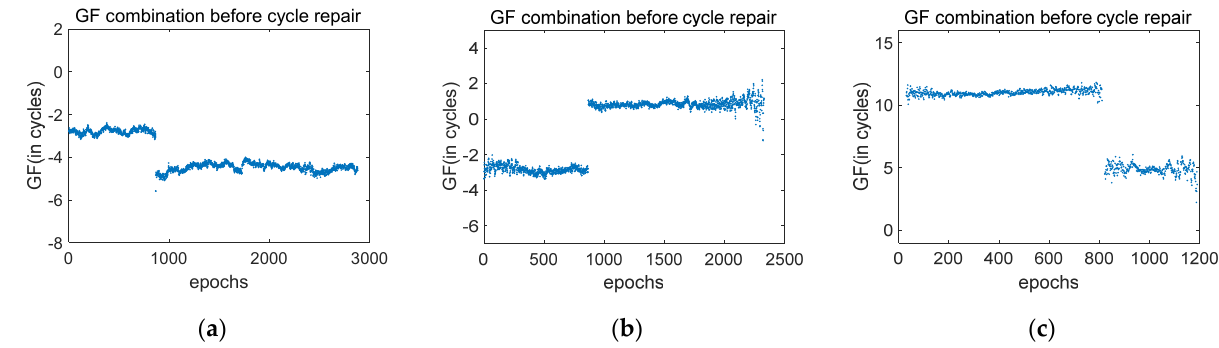
Figure 2. GF combination values before cycle slips were repaired.